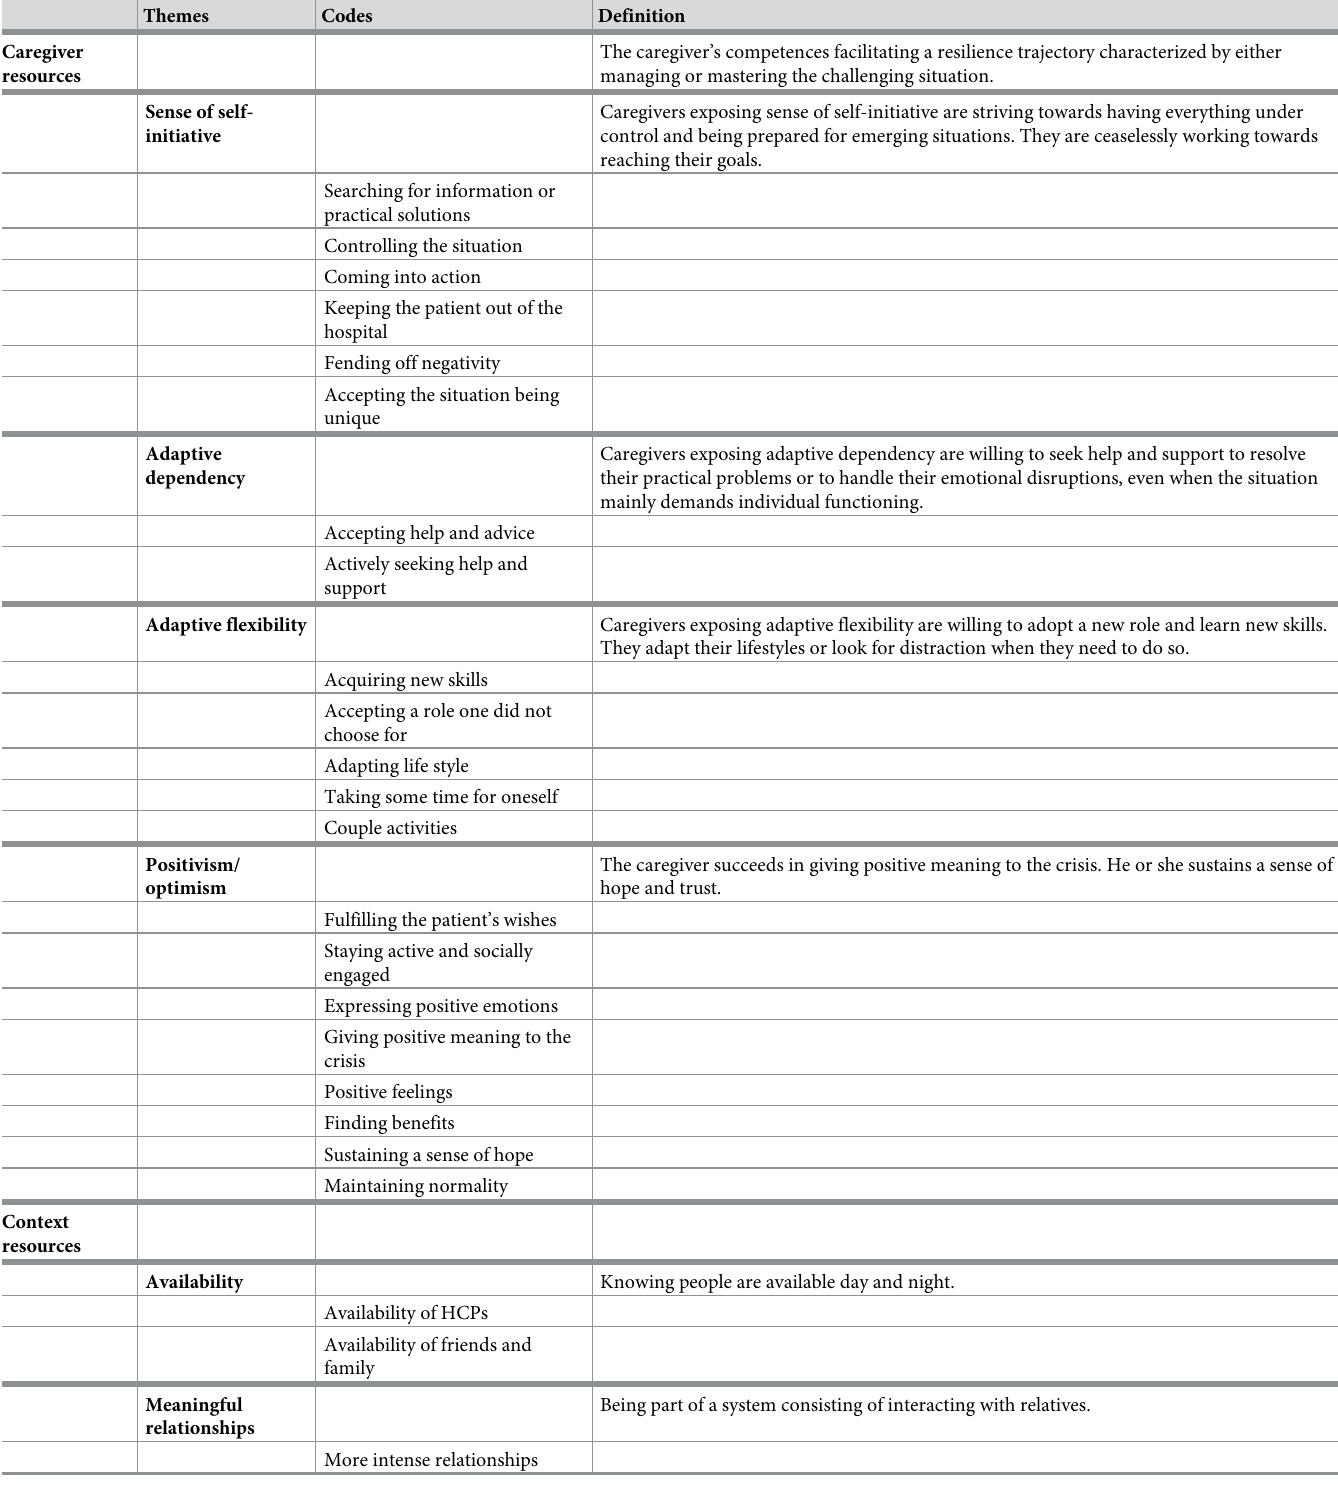
Table 4. Hierarchical map including concepts and